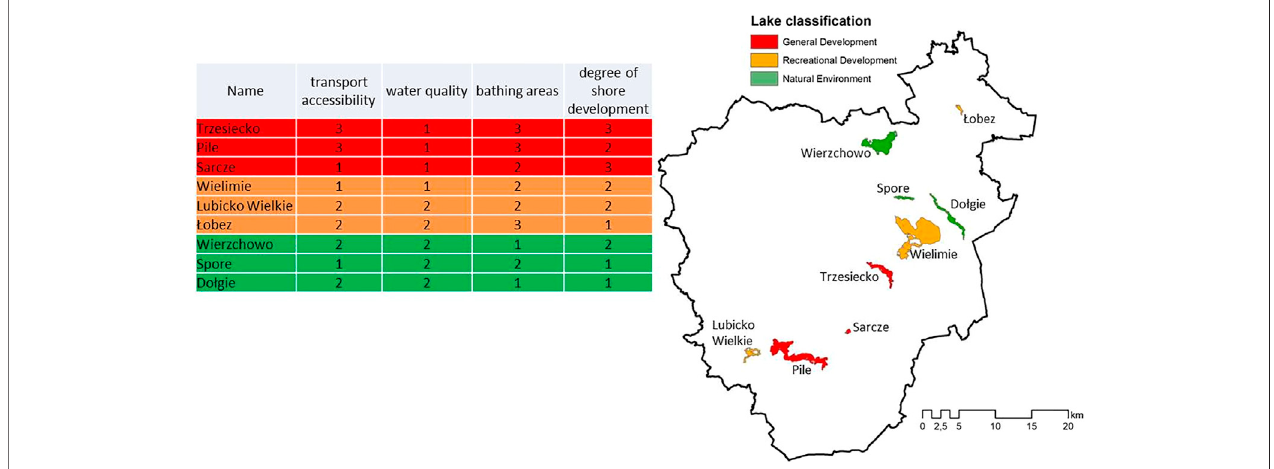
FIGURE 2 | Indexed scores based on transport accessibility, water quality bathing areas and degree of shore development for each category of lakes. Rates: 1 - low, 2 - medium, 3 - high.